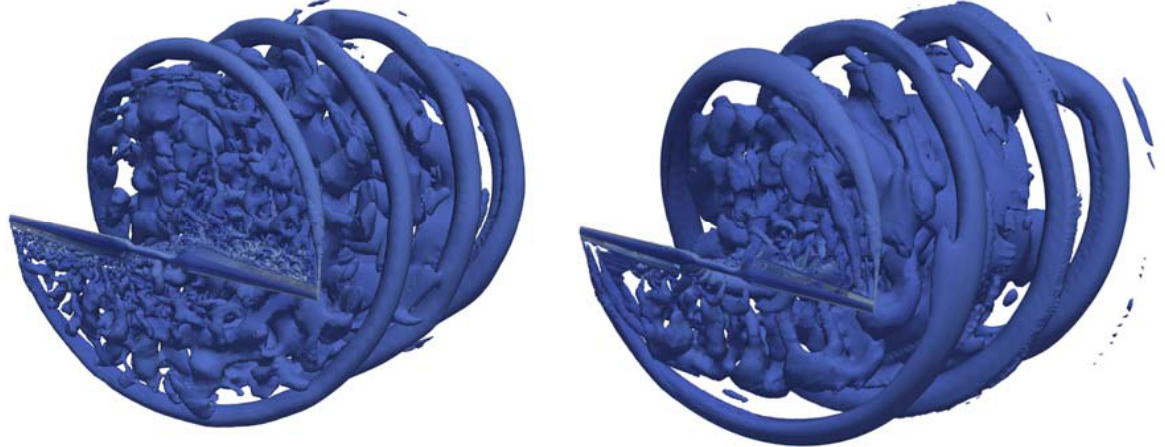
Figure 14. Vorticity contours when wind speed = 10 m/s and time = 1.4 s ( left : VLES; right : URANS).